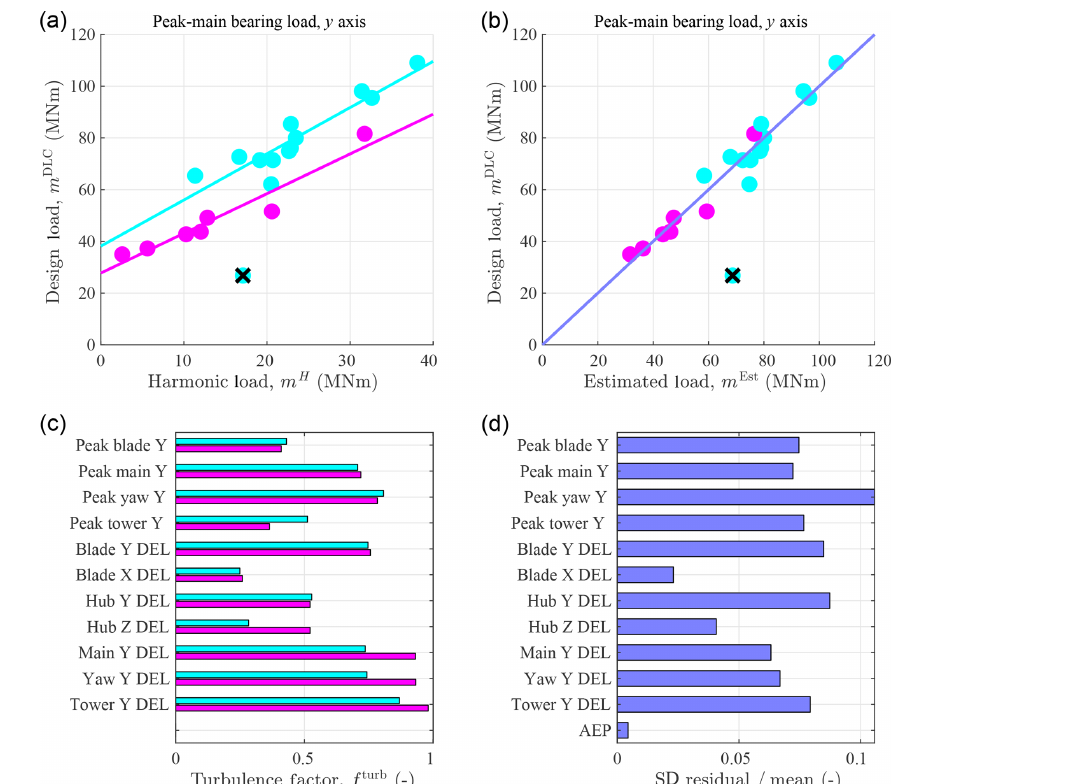
Figure 6. Peak main-bearing loads computed using DLC simulations versus the harmonic load (a) and transformed load estimates (b) for two-bladed rotors (cyan) and three-bladed rotors (magenta). The same color scheme is used to show the relative effect of turbulence on selected component loads (c) , as defined in Eq. (12), and the standard deviation of the residual normalized by the mean load is shown for the whole transformation set (d) . The loads presented in this study are specifically the moments about the specified